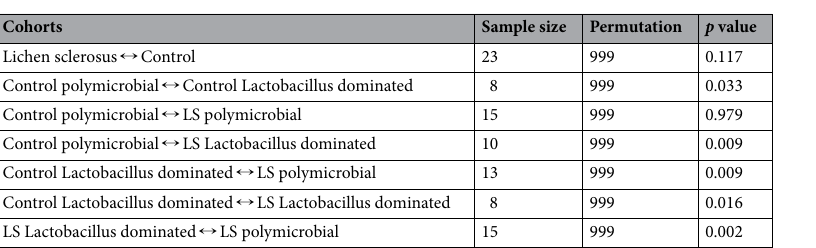
Table 2. PERMANOVA analysis data of the Bray–Curtis ß-diversity PCoA. The table lists for each cohort combination the number of included samples, the number of carries our permutations and normalized p value.